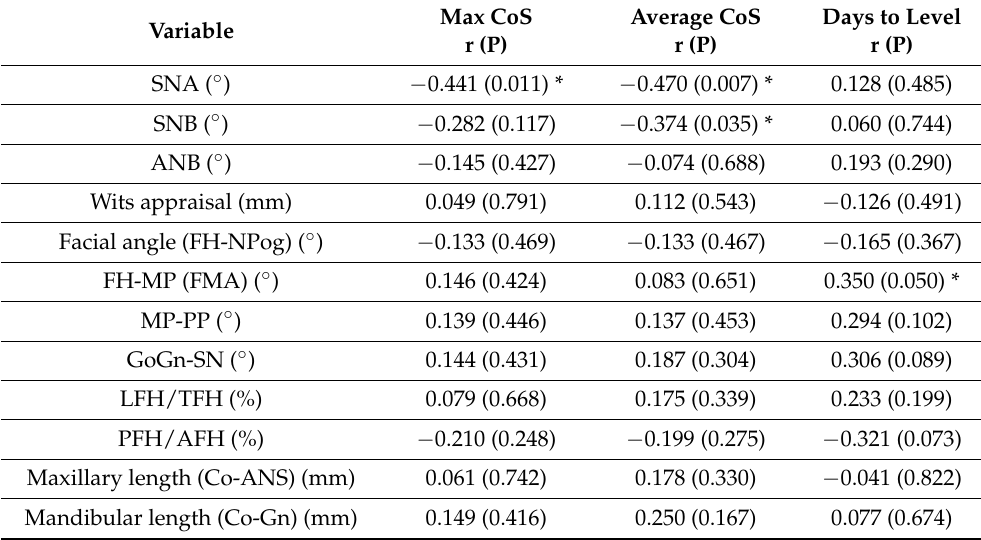
Table 2. Evaluation of the relationship between the CoS and the days to level the CoS with the selected craniofacial